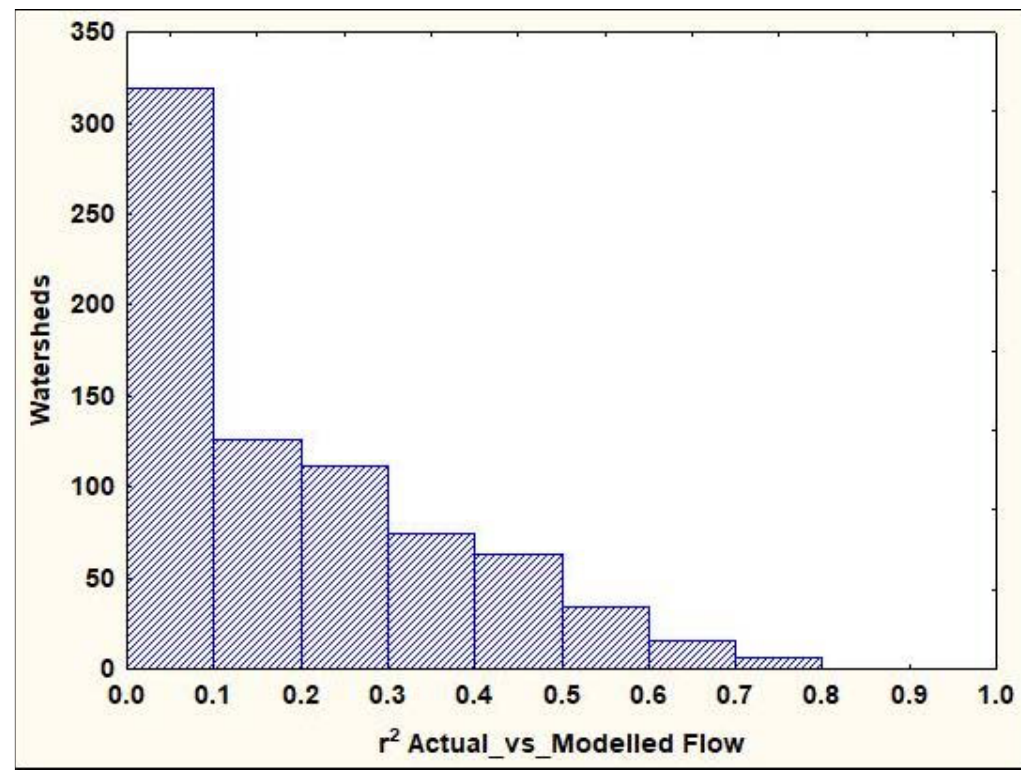
Figure 2. Histogram of the watersheds grouped by the r 2 values of the correlation between actual and modeled flow. The interval size is